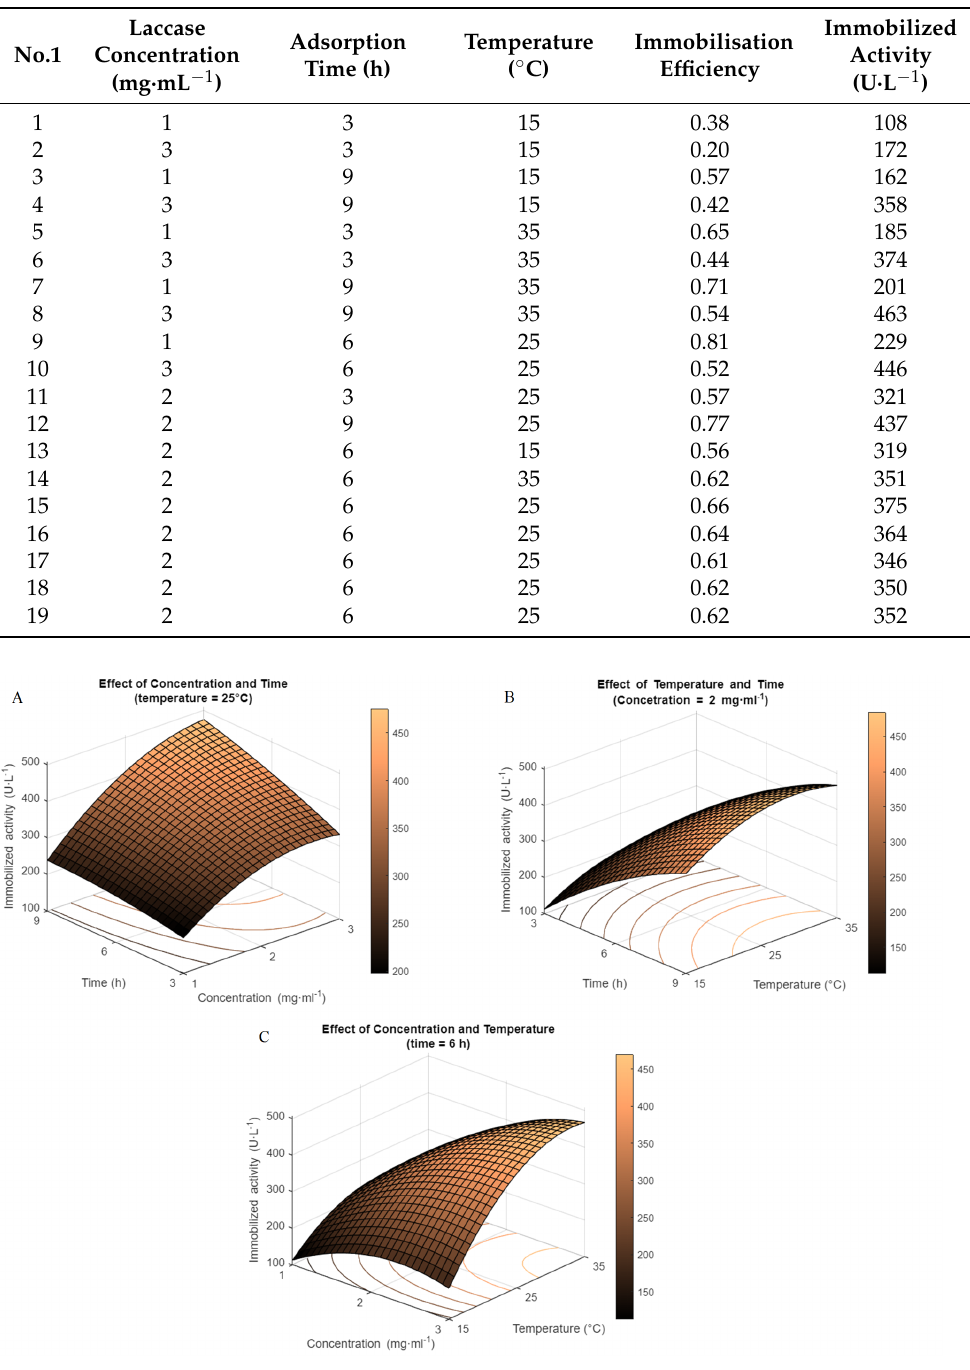
Table 1. Optimization of laccase adsorption on cellulose acetate membrane.